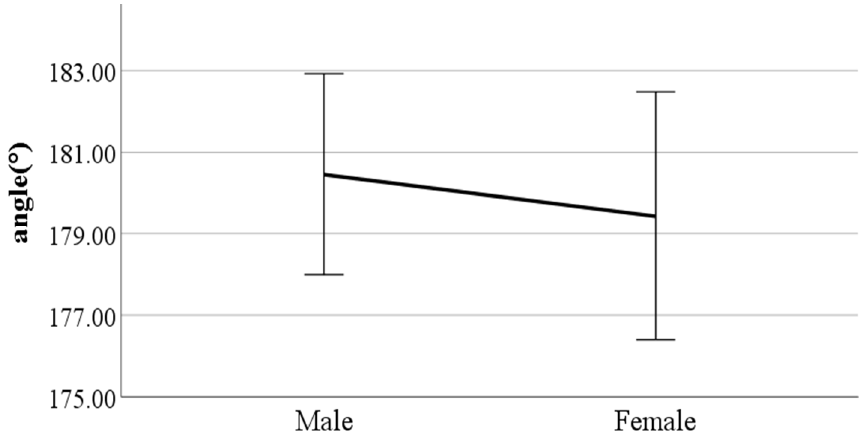
Figure 19. Gender difference in shoulder angle in the frontal plane at the double support phase (left foot forward) (F value: 4.72, DF: 289, p -value: 0.00).